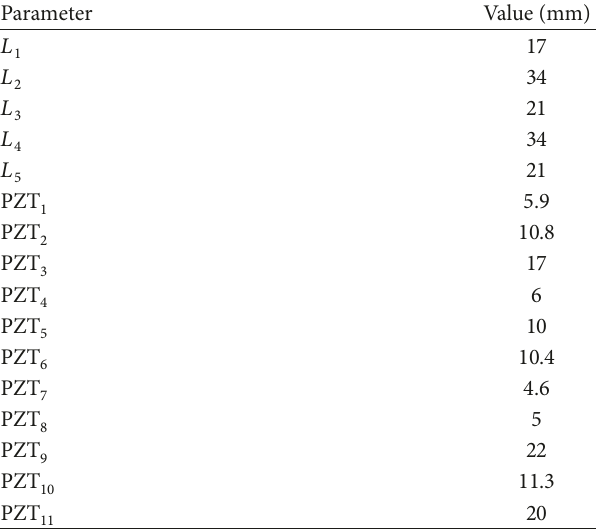
Table 1: Geometrical parameters of the